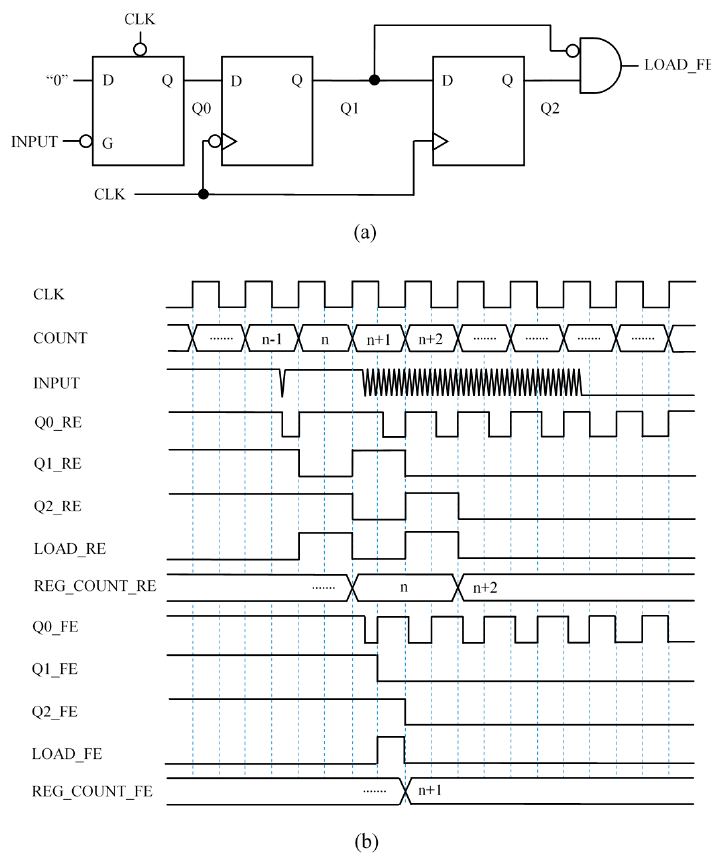
Figure 9. Capture Module 5—circuit triggered with the rising and falling edge of the clock signal to average two counts: ( a ) circuit and ( b ) example chronogram. average two counts: ( a ) circuit and ( b ) example